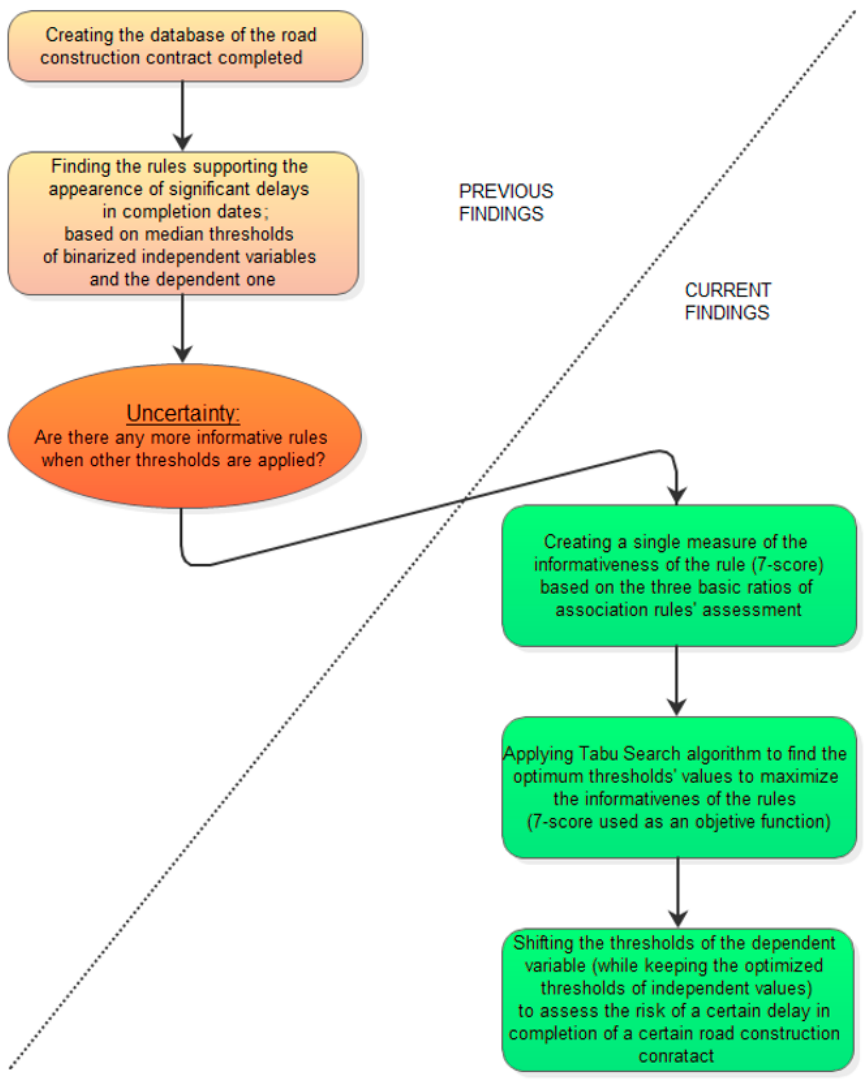
Figure 1. The sequence of the findings introduced and presented in the